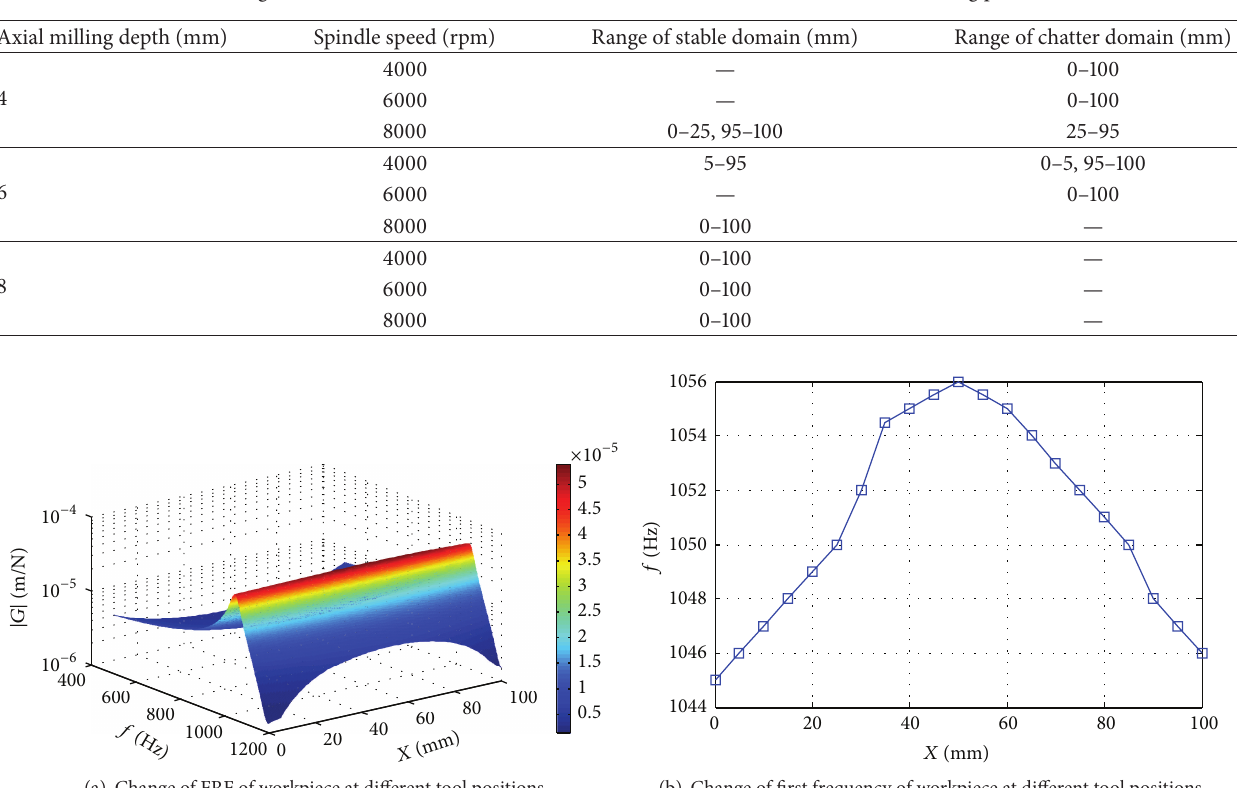
Table 3: Ranges of stable domain and chatter domain under different combinations of milling parameters.